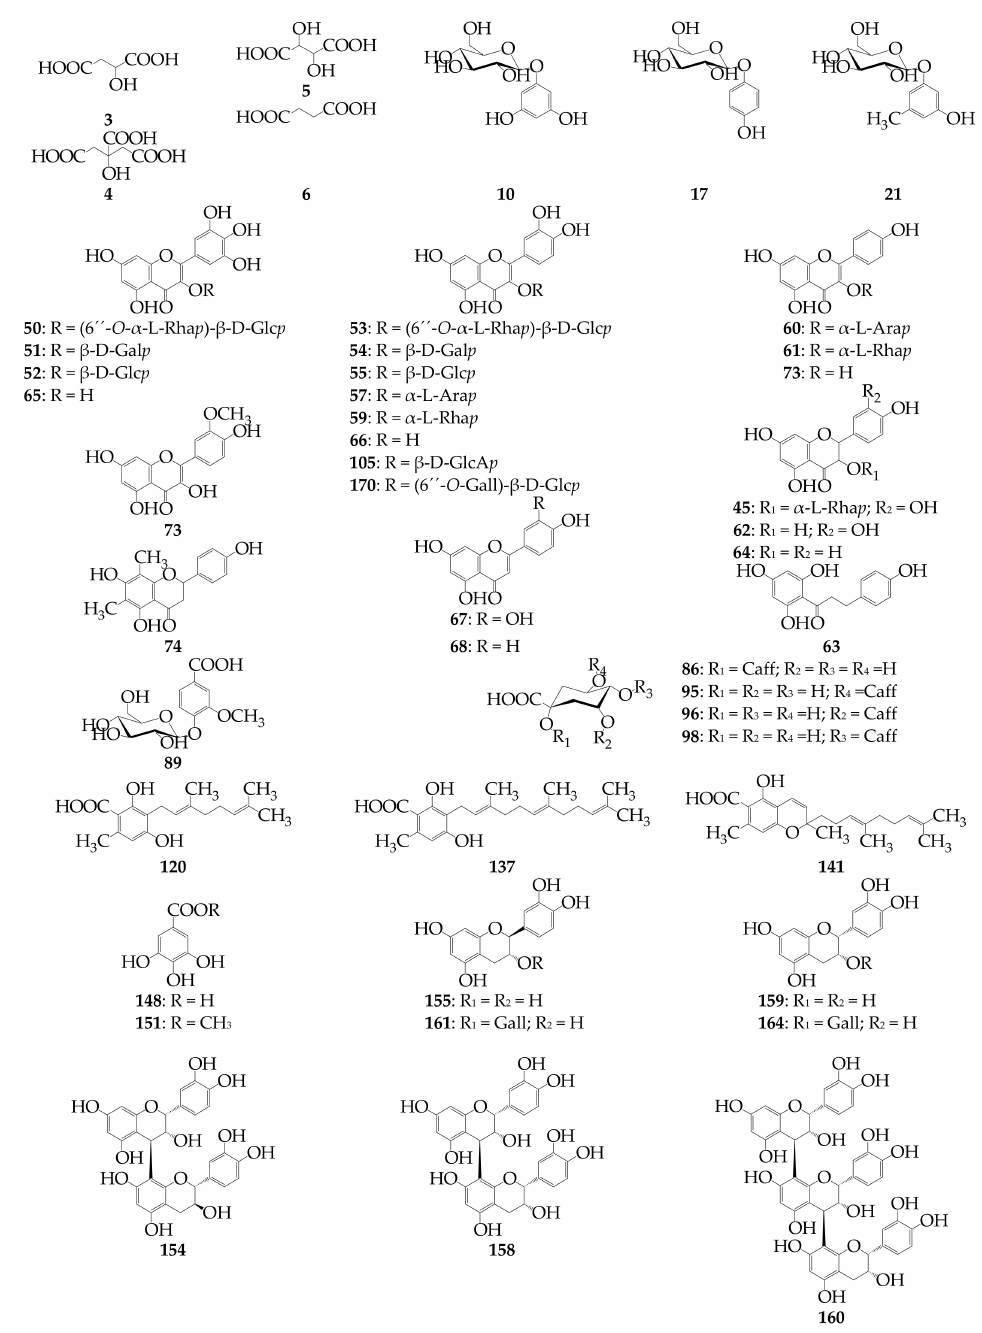
Figure 5. Structures of known compounds found in R. adamsii . Abbreviation used: Ara p —arabinopyranose; Caff—Caffeoyl; Gall—Galloyl; Gal p —Galactopyranose; Glc p —Glucopyranose; GlcA p —Glucuronopyranose; Rha p